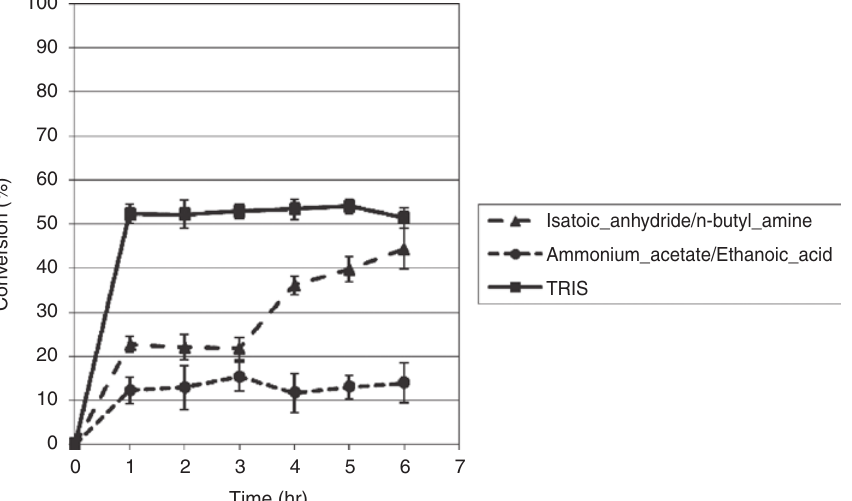
Figure 1: Scavenging of benzaldehyde from water/ethanol solvent mixture by applying different derivatization agents at 50 ° C and 1 h as the reaction